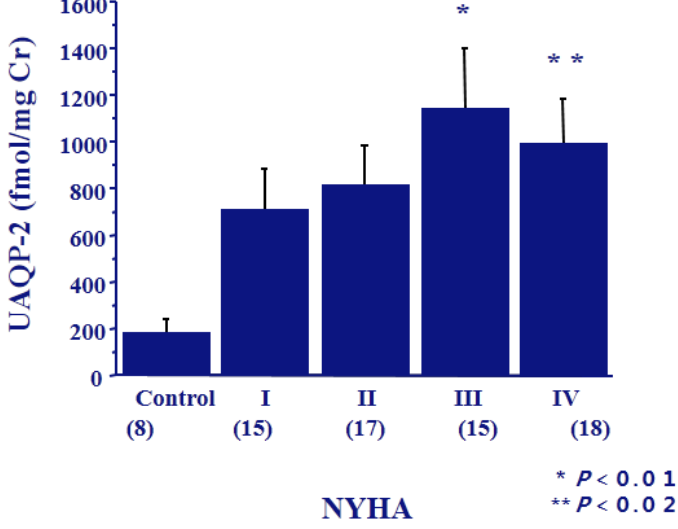
Figure 6. Urinary excretion of AQP2 in the patients with congestive heart failure. Cited from